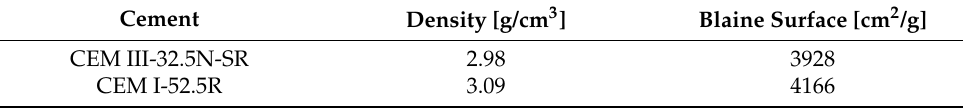
Table 2. Physical properties of the different cements.